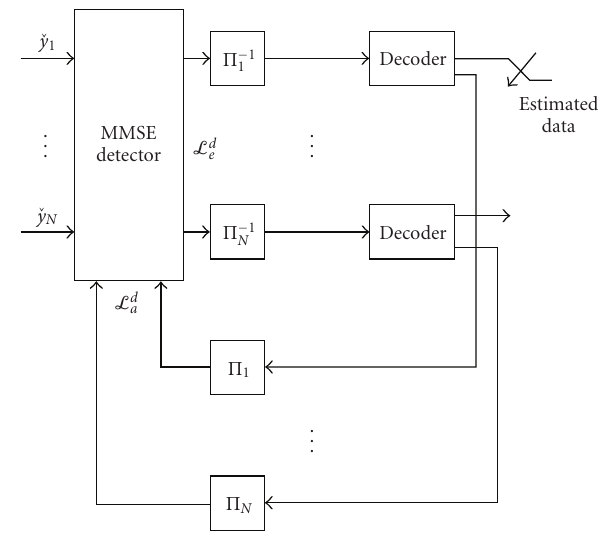
Figure 2: Iterative MIMO